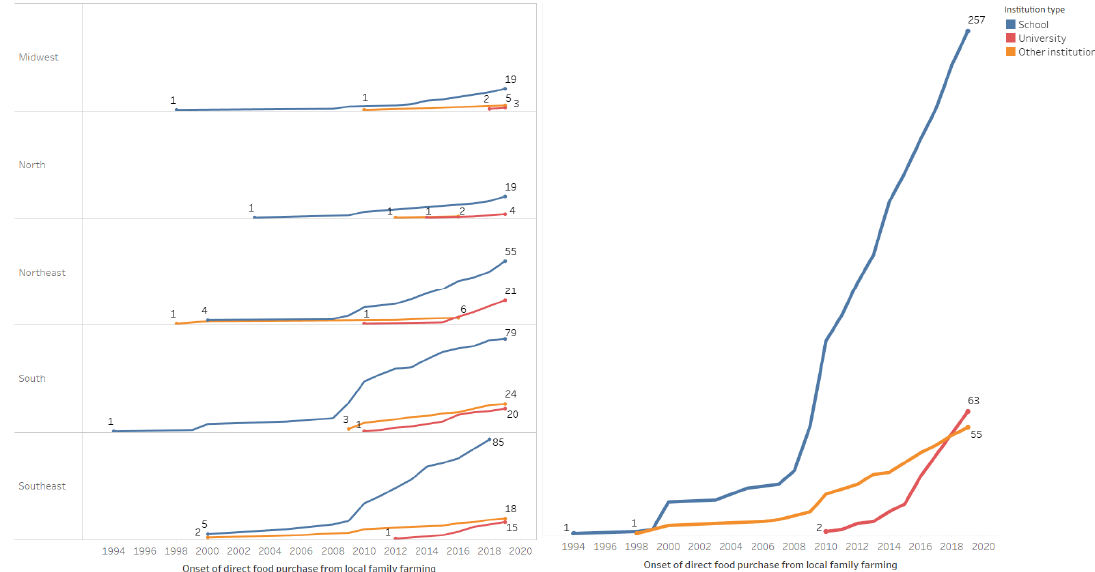
Figure 2. Accumulated number of managing units of public institutional food services per year of onset of direct food purchase from local family farming by type of institution and region of the country.